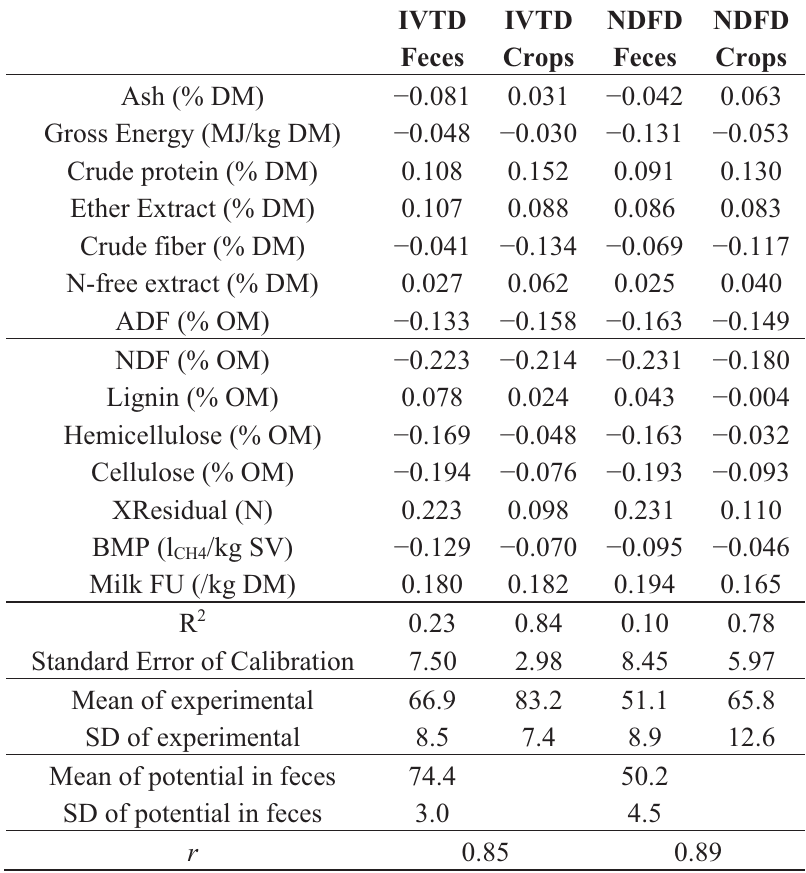
Table 3. Partial Least Square (PLS) models for digestibility in rabbit feces and crops with standardized coefficients and